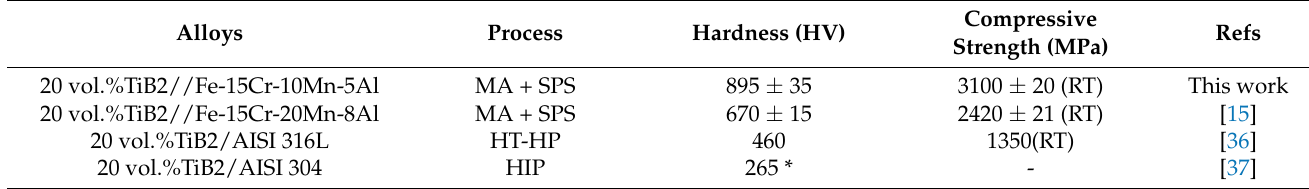
Figure 11. Relationship between test temperature and compressive strength of the sintered TiB 2 /Fe- 15Cr-10Mn-5Al composites with different TiB 2 . Table 2. The hardness and compressive strength of several TiB 2 /Fe-Cr composites. Alloys